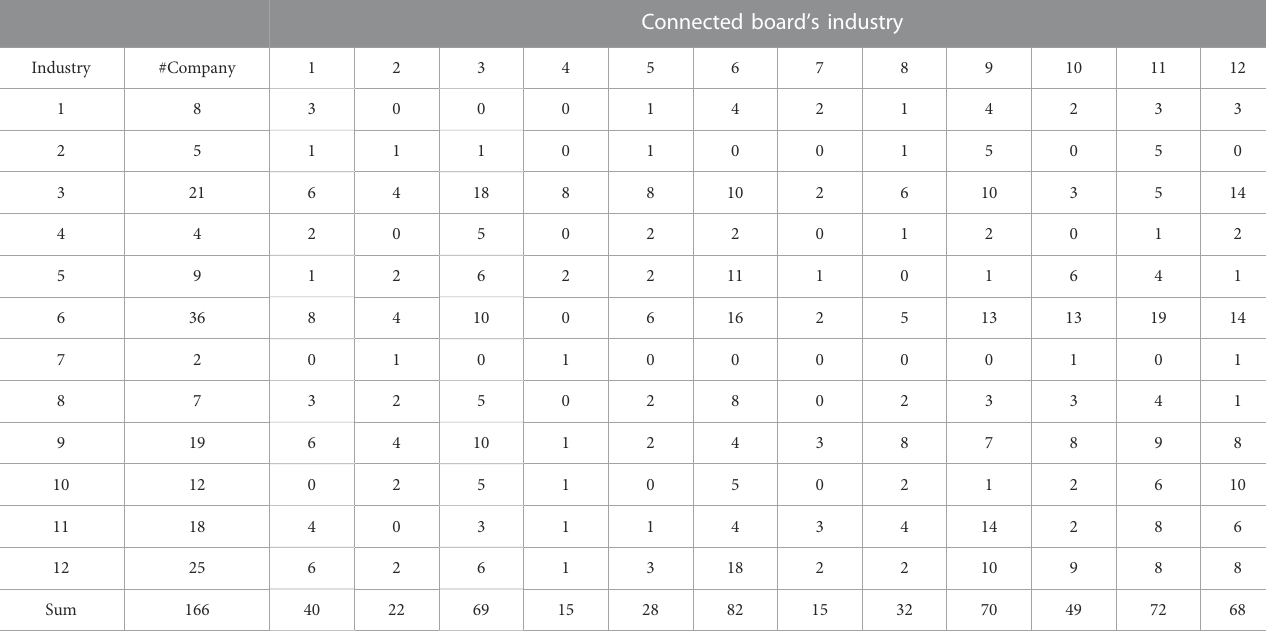
TABLE 8 Adjacency matrix of off-diagonal elements in the transition matrix at the industry level for the year 2007. Industry